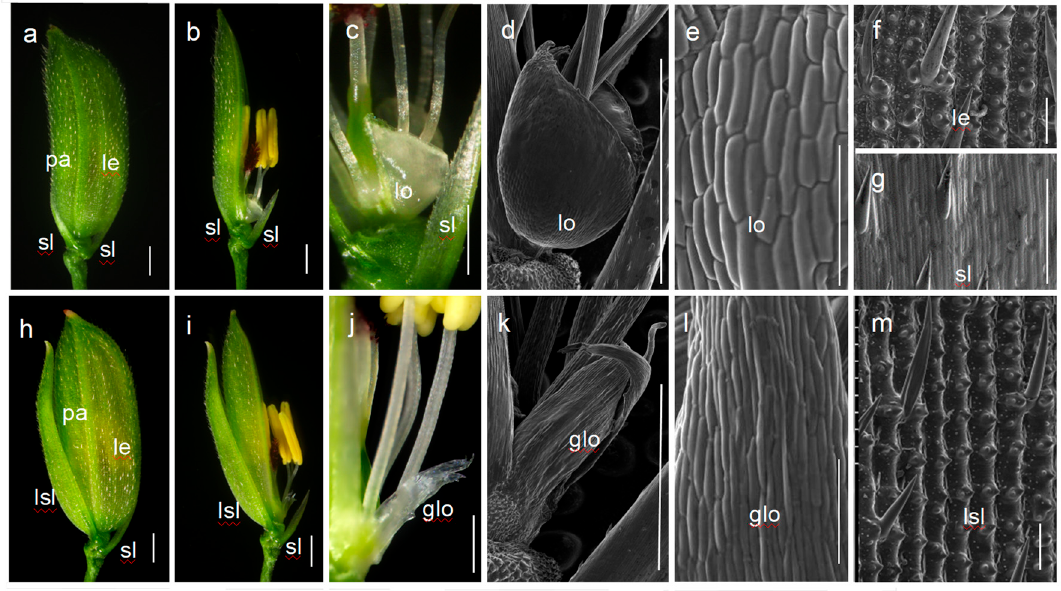
Figure 1. Morphological analysis of spikelet of the wild-type (Xinong 1B) and noh1 mutant. ( a–c) the